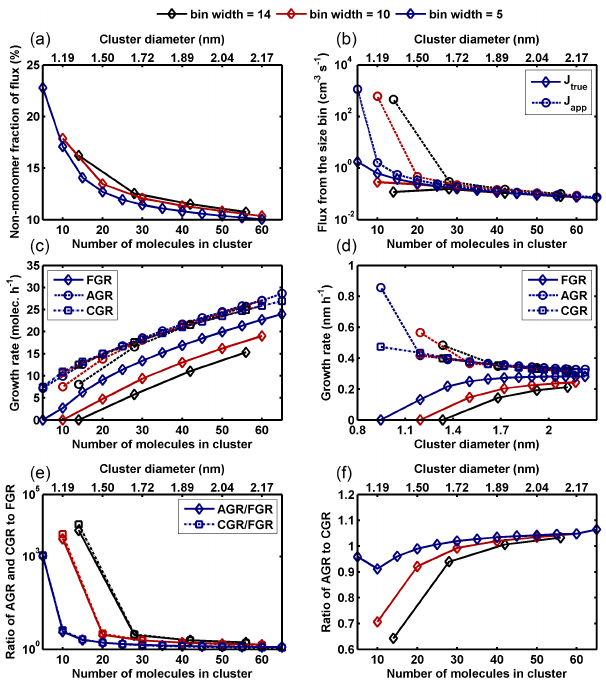
Figure 3. The effect of size bin width (shown as different colors) on quantities describing cluster growth: (a) the non-monomer frac- tion of flux from each size bin; (b) the true collision–evaporation flux from each size bin ( J true ; solid line) and the fluxes calculated from the appearance times of clusters ( J app ; dashed line); (c, d) the flux-equivalent growth rate (FGR; solid line), the growth rate de- rived from the appearance times of clusters (AGR; dashed line), and the growth rate calculated based on irreversible vapor condensation (CGR; dotted line); (e) the ratios of AGR to FGR (solid line) and CGR to FGR (dotted line); (f) the ratio of AGR to